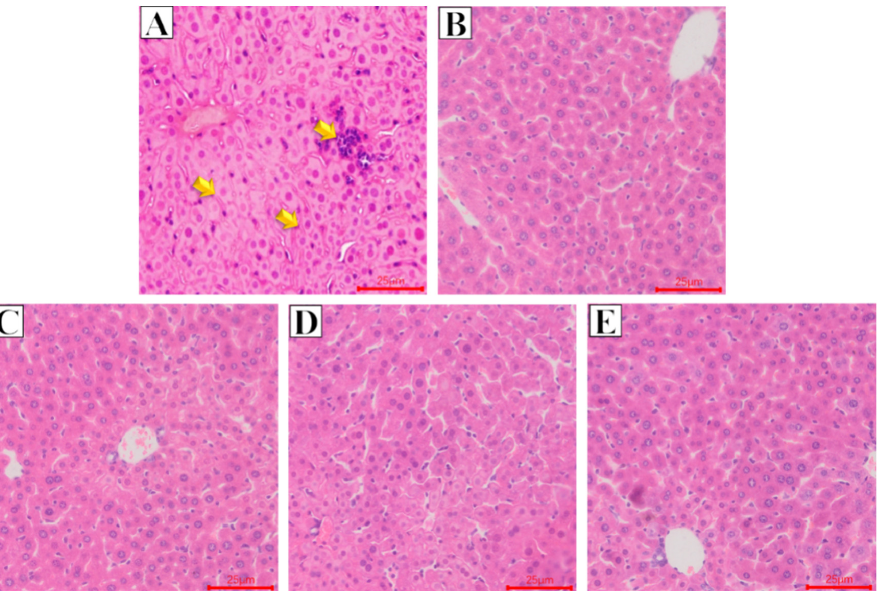
Figure 7. Effect of Glycine nano-selenium on pathological changes of liver tissue in mice immunized with H9N2 avian influenza virus vaccine and challenged with H9N2 avian influenza virus ( A – E , 200×); ( A ) Control challenged group showed amyloidosis in some hepatocytes, swelling of hepatocytes, disappearance of hepatic cord, and inflammatory cell infiltration (the lesion site is marked by yellow arrow) (Figure 7A); ( B – E ) The liver of mice in the positive, low, medium, and high dose challenged groups showed arranged neatly hepatic cords, and clear outline of hepatocytes. No obvious pathological changes were found (n = 5).